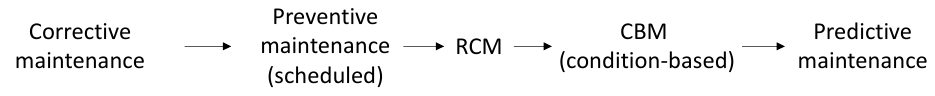
Preventive Corrective maintenance Figure 1. A simple timeline showing the evolution of Figure 1. A simple timeline showing the evolution of maintenance.